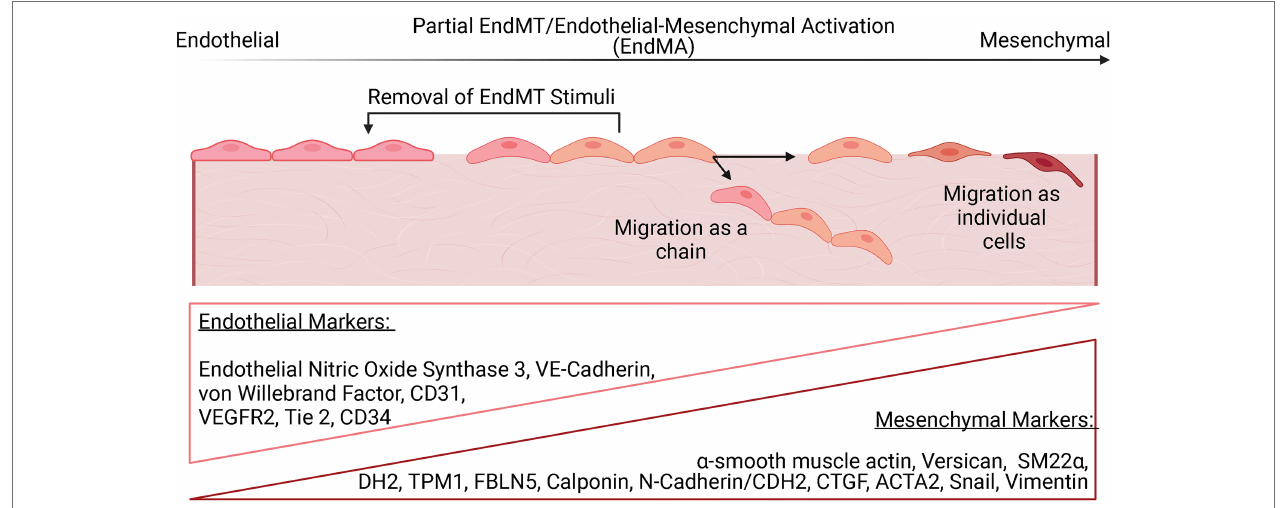
FIGURE 2 | The EndMT continuum. EndMT is thought to exist on a spectrum with evidence for partial activation of EndMT that may be reversed with removal of the EndMT stimuli. Endothelial cells that have undergone partial EndMT can migrate as a chain without loss of cell-cell adhesion. ECs that undergo EndMT can also migrate as individual cells. Complete EndMT is defined as the presence of an entirely mesenchymal state. The progression of EndMT is evaluated by the monitoring the expression of various endothelial and mesenchymal markers, with ECs that have undergone partial EndMT expressing some level of both types of